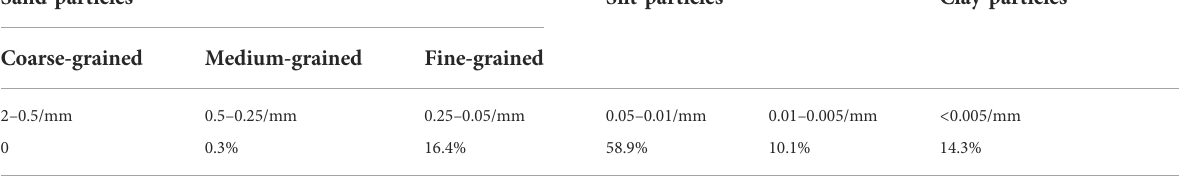
TABLE 1 Results of the grain analysis performed on samples obtained from the Zhangjiayuan gully debris fl ow. Sand particles Silt particles Clay particles Coarse-grained